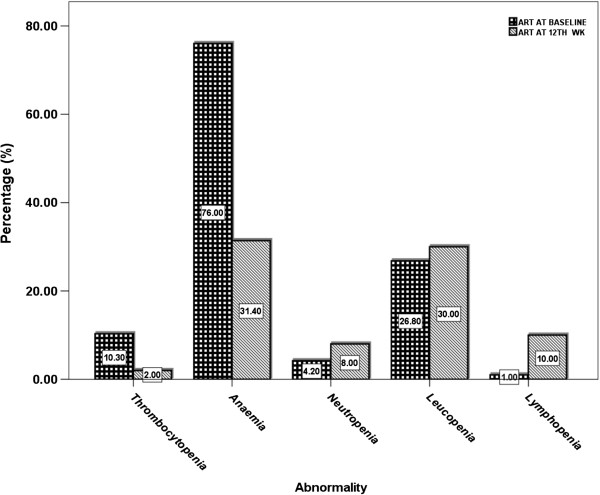
Distribution of haematologic abnormalities (Cytopenia) observed in HIV+ subjects taking Winniecure ART. This figure illustrates the distribution of haematological abnormalities (Cytopenia in percentages %) observed in HIV+ subjects taking Winniecure ART. The bars compares the abnormality at baseline (1st wk) and at the 12th wk of ART administration. Abnormalities presented include anaemia, neutropenia, leucopenia, lymphopenia and thrombocytopenia.